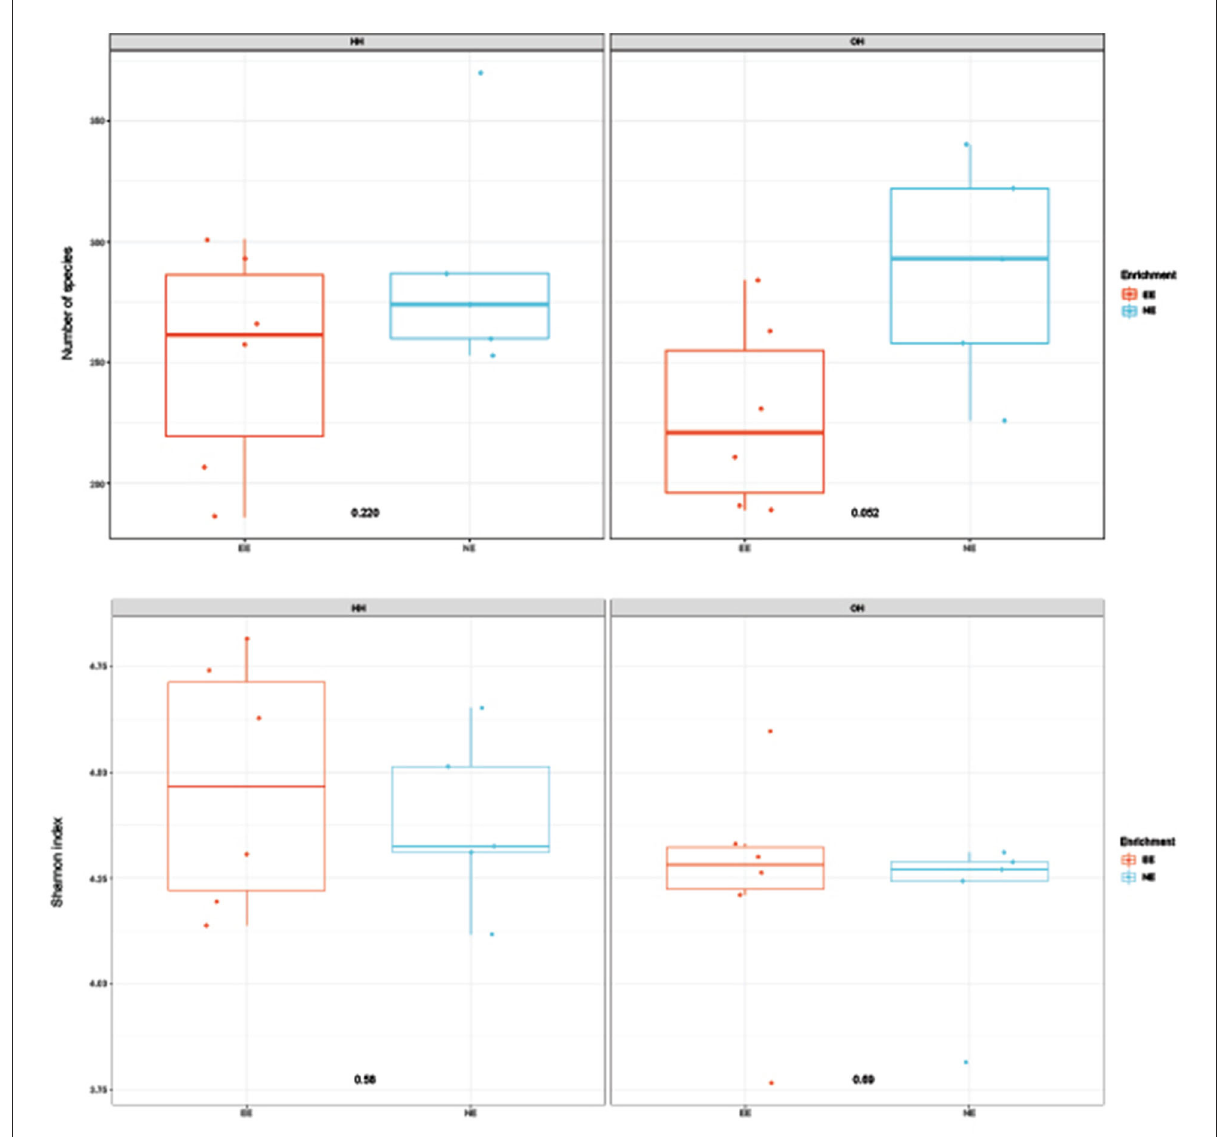
FIGURE2 Diversity of microbiota in fecal samples collected on day 14 of age; observed richness (top boxplot) and Shannon index (bottom boxplot). P -values of comparison between pens with a dark brooder (EE) and without a brooder (NE) within the hatchery-hatched (HH) resp. on-farm hatched treatments (OH) are indicated in the boxplots. Each point represents a pen (pooled sample of six chickens per